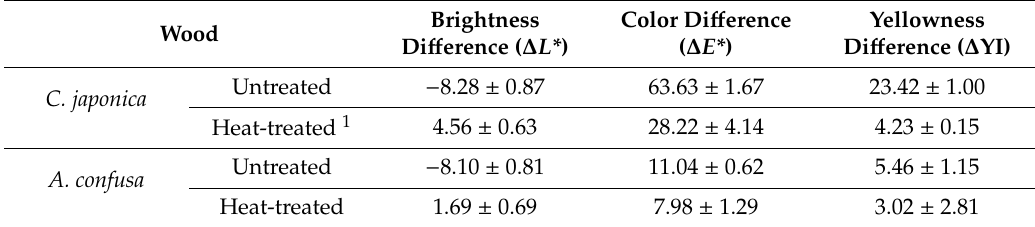
Table 5. Lightfastness of untreated and heat-treated Japanese cedar ( Cryptomeria japonica ) and